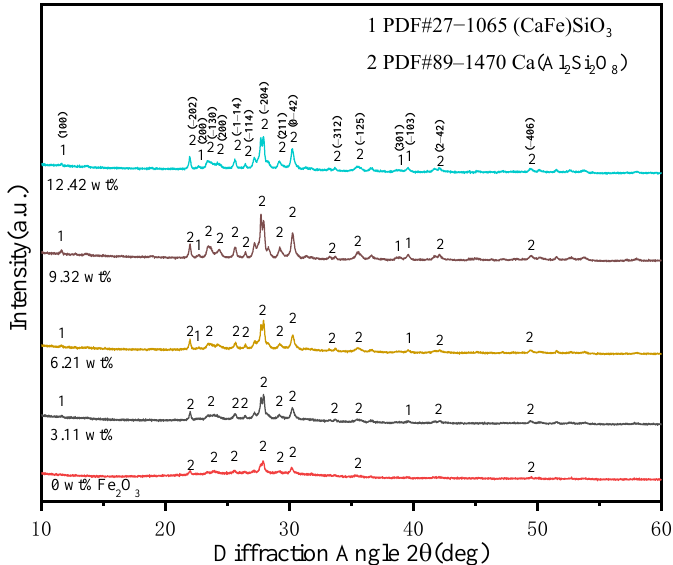
Figure 2. XRD patterns of glass-ceramics with different Fe 2 O 3